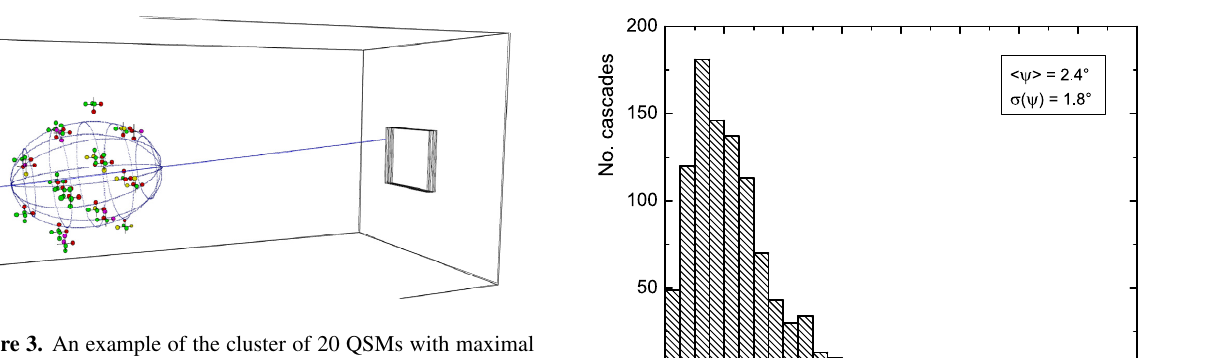
Figure 2. Longitudinal profiles of spatial distribution of the Cherenkov radiation from cascades.